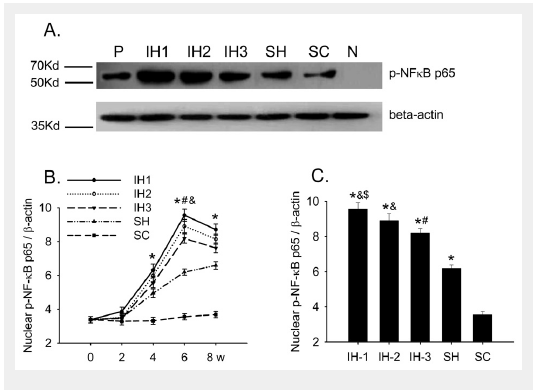
Temporal changes of phosphorylated NF-κB p65 in nuclear extracts of aorta endothelial cells. (A) A representative Western blot showed that increased levels of p-NF-κB p65 in nucleus were observed in IH groups as compared to those in SH and SC group. Positive control, referred to as P, was whole-cell extracts from cultured hela cells stimulated with 10 ng/ml TNF-α. The whole-cell extracts further treated with lamda phosphatase were used as negative control, labelled as N in the blot. The levels of β-actin were used as the internal standard of protein content in each lane. (B) The intensity of phosphorylated NF-κB p65 was normalised to that of β- actin, which was then plotted as mean ± SE to show the activity changes of this transcription factor at various time points (* p <0.05 IH1, 2, 3 and SH group vs SC group; # p <0.05 IH 1, 2, 3 vs SH group; & p <0.05 IH1 vs IH3 group, n = 7 or 8 in each group). (C) The normalised nuclear levels of phosphorylated NF-κB p65 at 6 th week were also re-plotted as bar graphs (* p = 0.01 compared with SC group; # p = 0.05 compared with SH group; & p = 0.01 compared with SH group; $ p = 0.05 compared with IH-3 group, n = 7 or 8 in each